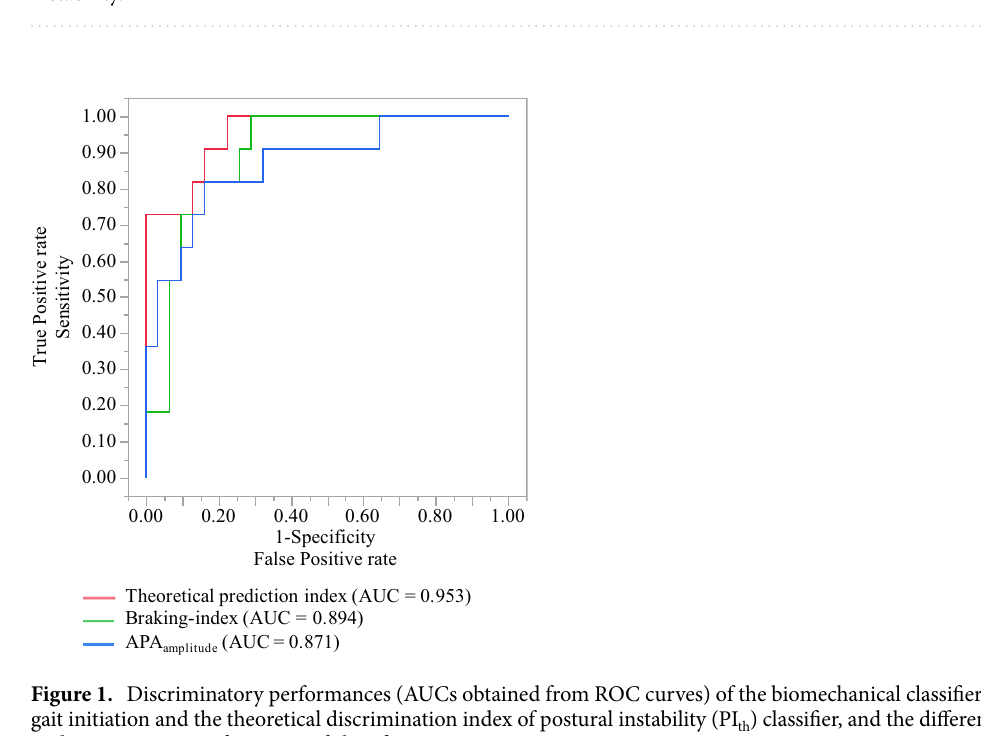
Table 3. Biomechanical classifiers of postural instability. *Theoretical prediction index classifier of postural instability.